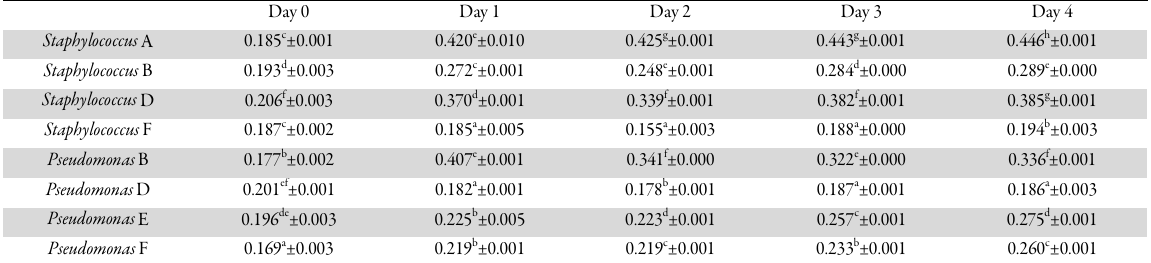
Table 3. Growth rate of Staphylococcus and Pseudomonas spp. before curing